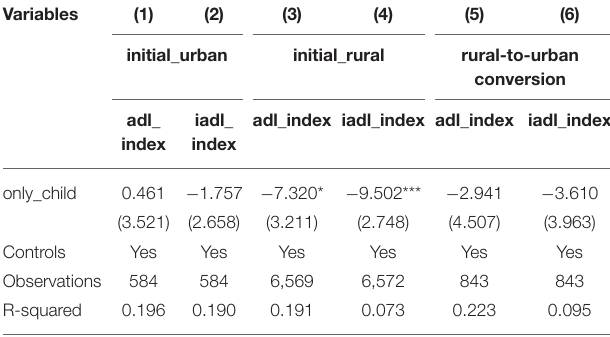
TABLE 5 | The health effect considering initial hukou and rural-to-urban conversion.